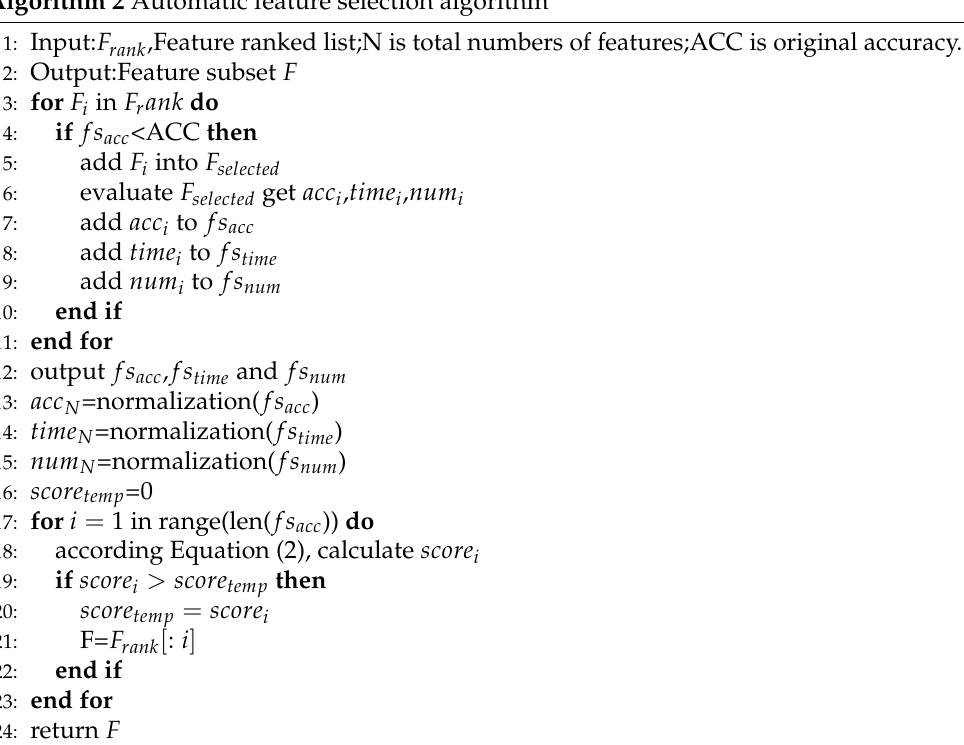
Algorithm 2 Automatic feature selection